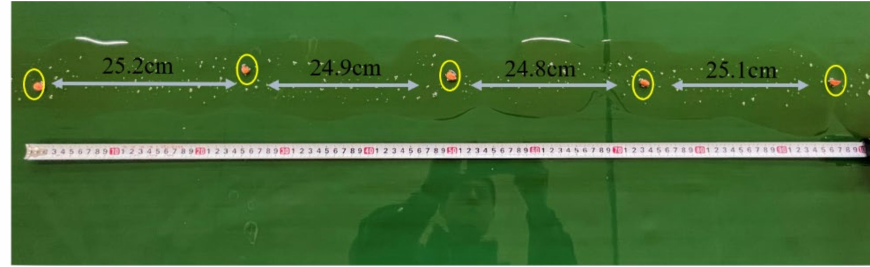
Figure 12. Sowing effect of bench